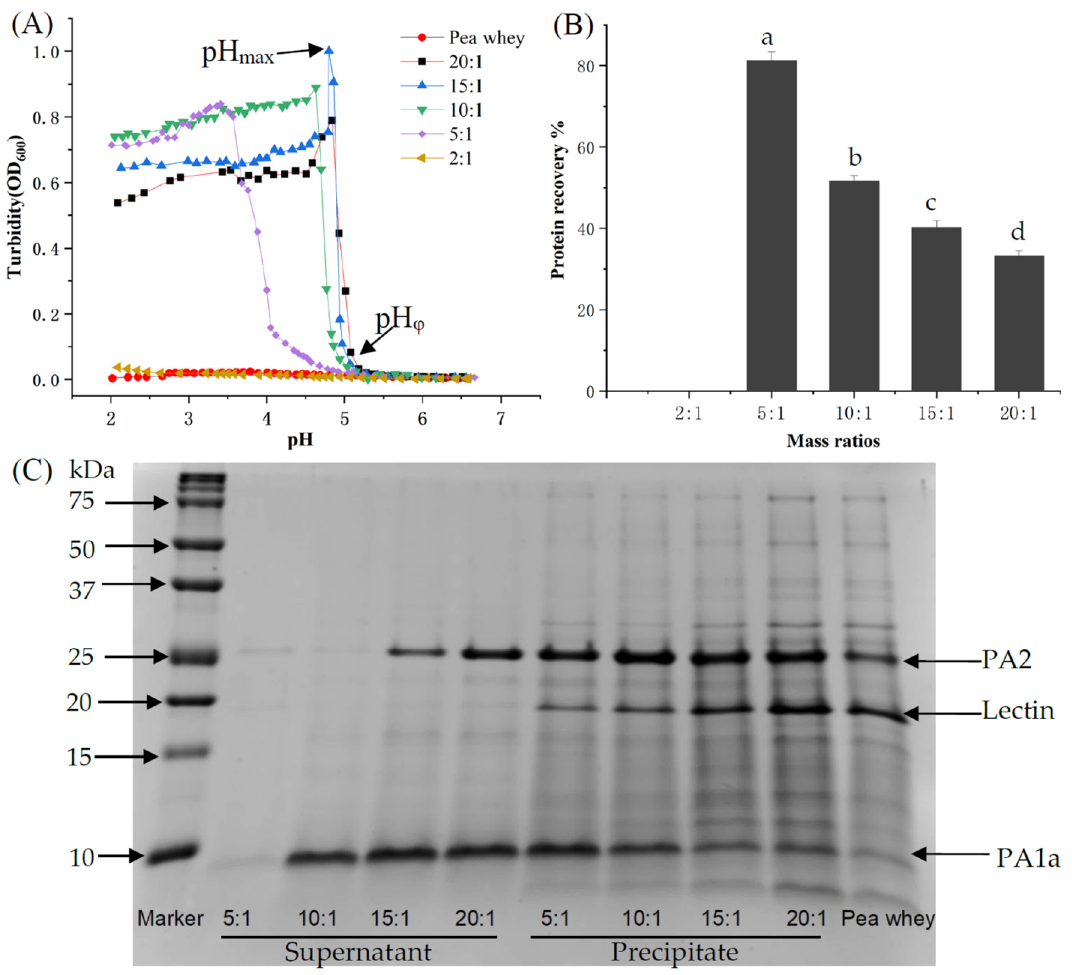
Figure 1. ( A ) Turbidity, ( B ) protein recovery, and ( C ) SDS-PAGE of the PA/DS complexation system. Different letters between different groups indicate significant differences ( p < 0.05).